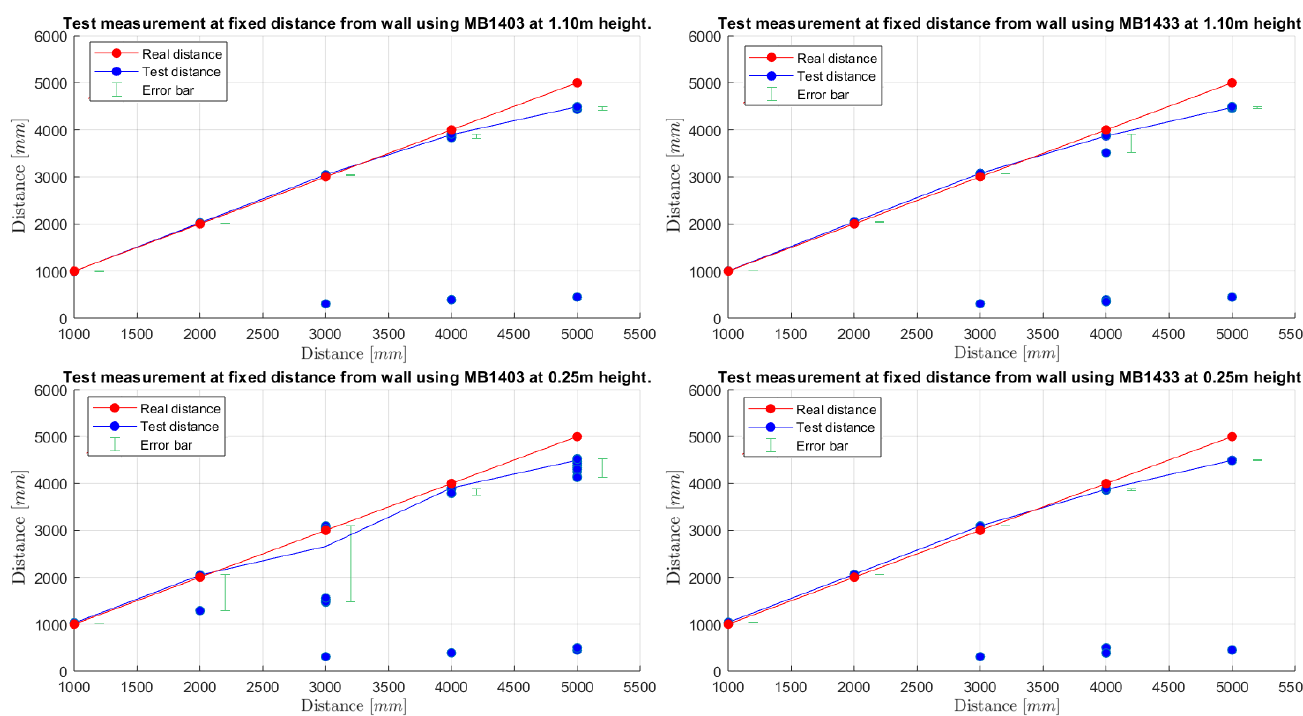
Figure 5. Experimental distance estimates collected with stationary ultrasonic sensors at different distances and heights from the